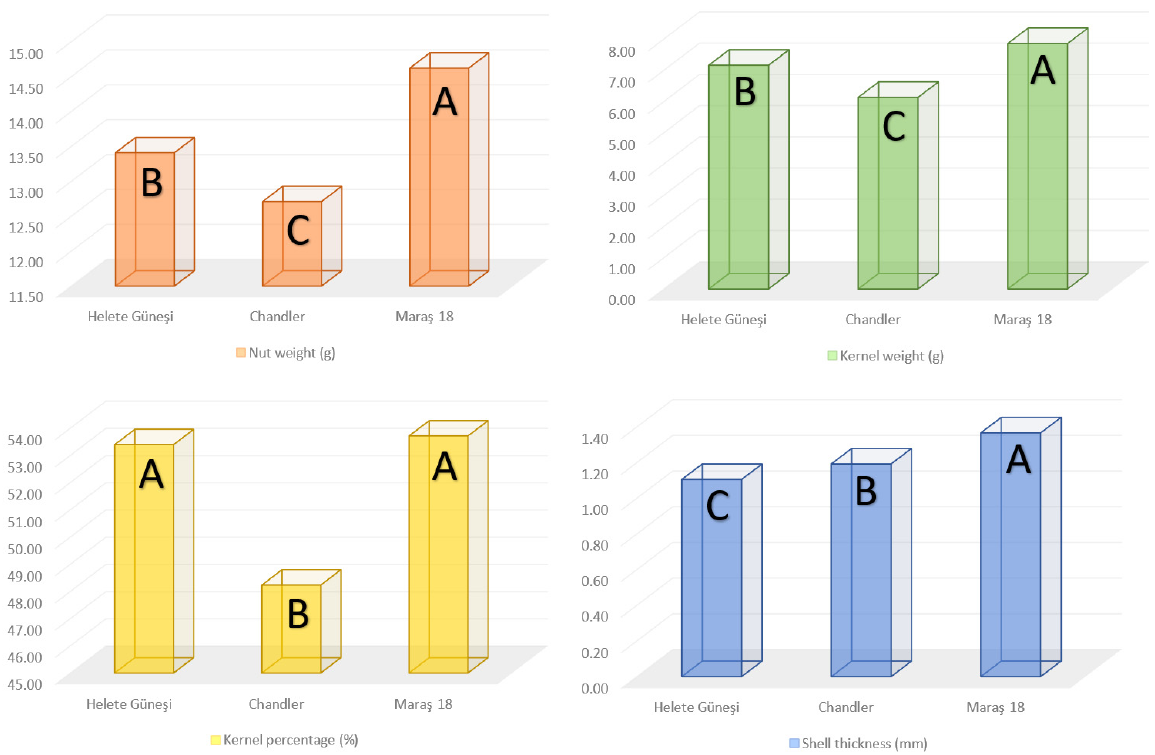
Figure 3. A comparison of three cultivars in terms of kernel weight, shell thickness, shelled nut weight, and kernel percentage. Different letters over the columns represent significant differences based on the LSD multiple range test ( p = 0.05). Table 4. Pomological traits of ‘Helete Güne ş i’ and its parents.